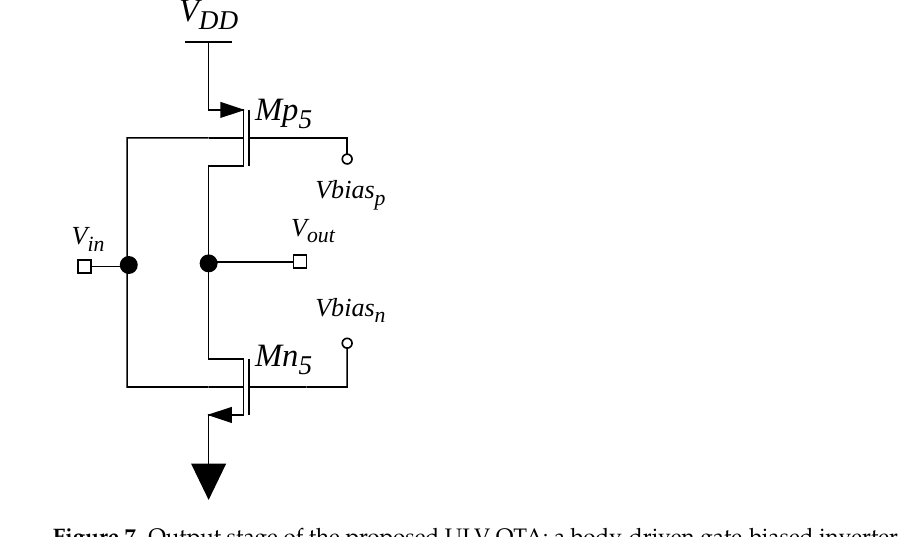
Figure 7. Output stage of the proposed ULV OTA: a body-driven gate-biased